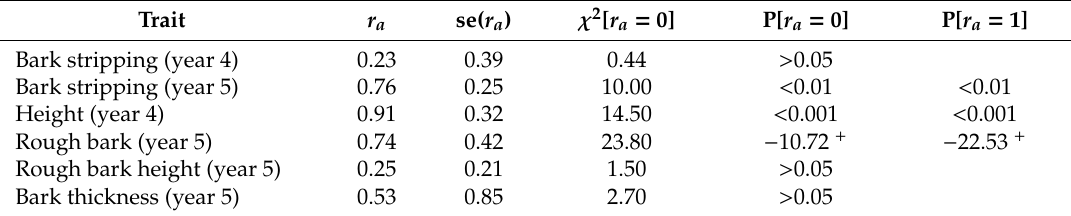
Table 5. Across-site (Type-B) additive genetic correlations ( r a ) for each trait assessed in both Beulah and Payanna and the corresponding standard error (se). The two sister trials share 98 families and were the same age. The chi-square value ( χ 2 ) and the p -value that the genetic correlation is equal to zero (P[ r a = 0]) are indicated. When significantly di ff erent from zero ( p < 0.05), the significance of the genetic correlation from 1 (P[ r a = 1]) is also presented. A “ + ” indicates that the di ff erence of the genetic correlation for the binary rough bark from 0 or 1 was important based on the